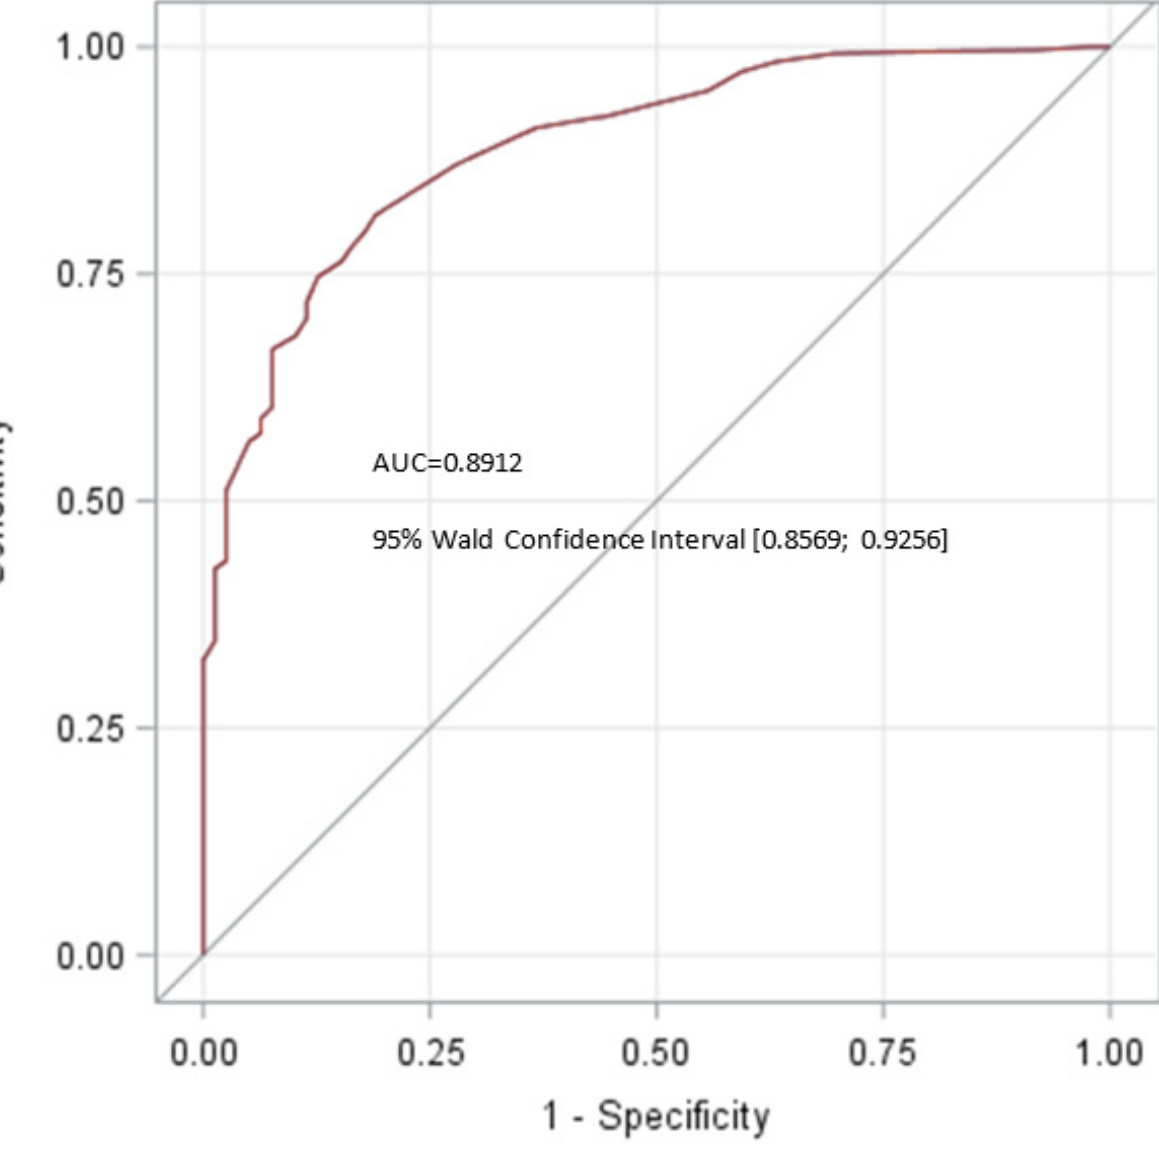
Figure 4. ROC analysis for predicting histology of a testicular neoplasm by its size. The ROC curve with an AUC of 0.8912 showed that tumour size is in fact a useful tool for assessing the biologic behaviour of small testicular neoplasms. Using a tumour size of 16 mm as threshold between benign and malignant tumours, the sensitivity and specificity of this factor were 81.5% and 81.0%, respectively (Youden index: